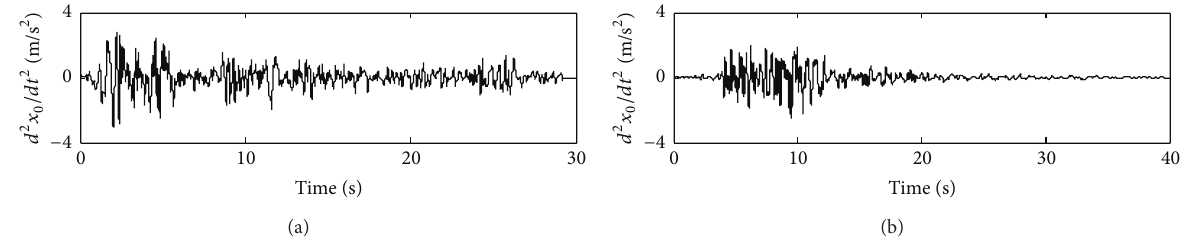
Figure 5: (a) El Centro and (b) Northridge earthquake excitations input to the